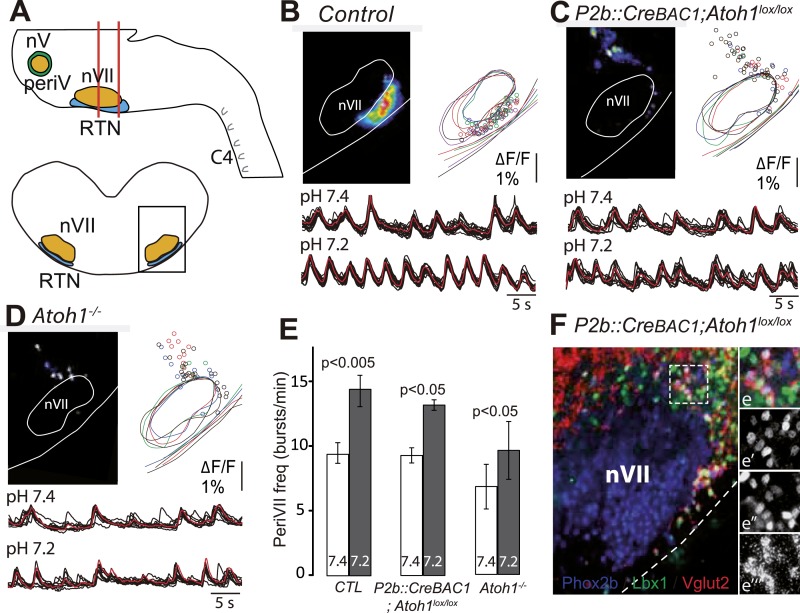
The dorsally misplaced periVII cells in P2b::CreBAC1;Atoh1lox/lox embryos are rhythmic and respond to a pH challenge.(A) Cartoon of the brainstem (top) showing medullary slice preparation (delimited by vertical red lines) used for calcium imaging of dorsally misplaced mutant cells (bottom, black box). (B and C) Above, ΔF/F changes and activity maps and below, superimposed traces showing spontaneous rhythmic fluorescence changes (traces corresponding to individual periVII cells in black and average trace in red) at pH7.4 (top, 7.4) and pH7.2 (bottom, 7.2) in E15.5 transverse slices from control (B) or P2b::CreBAC1;Atoh1lox/lox (C) preparations. The rhythmic cells are found ventrally in the controls and are massively displaced dorsally in the mutants. (D) Same experiment for Atoh1−/− preparations, showing fewer rhythmic cells that are less well synchronized. In panels B–D, the matched colors of the circles and the outlines of nVII and the medullary surface represent individual experiments (B, n = 9; C, n = 5; D, n = 5). (E) Histograms showing that the frequency of the oscillations of periVII cell is not significantly different at pH7.4 (7.4, white bars) between controls (CTL) and P2b::CreBAC1;Atoh1lox/lox or Atoh1−/− mutants and is increased by acidification to pH7.2 (7.2, gray bars) in all cases. (F) Combined fluorescent ISH for Vglut2 (red) and immunofluorescent staining of Phox2b (blue) and Lbx1 (green) on coronal sections of an E15.5 P2b::CreBAC1;Atoh1lox/lox hindbrain showing Vglut2 expression by the dorsally misplaced Phox2b+/Lbx1+ cells; (e–e′′′), close ups of the boxed area showing the overlay (e), Phox2b (e′), Lbx1 (e′′) and Vglut2 (e′′′) expression.